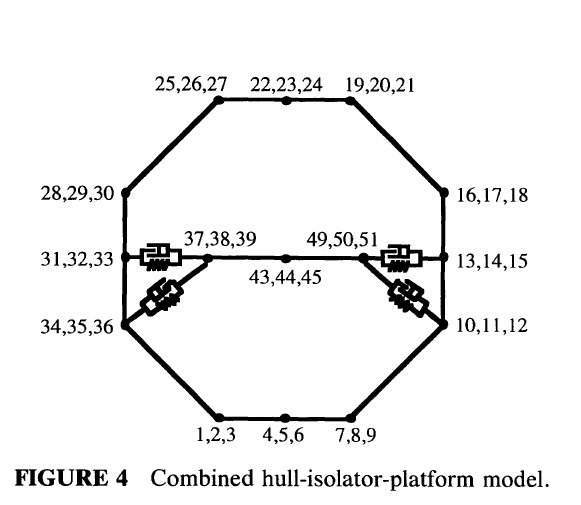
FIGURE 4 Combined hull-isolator-platform